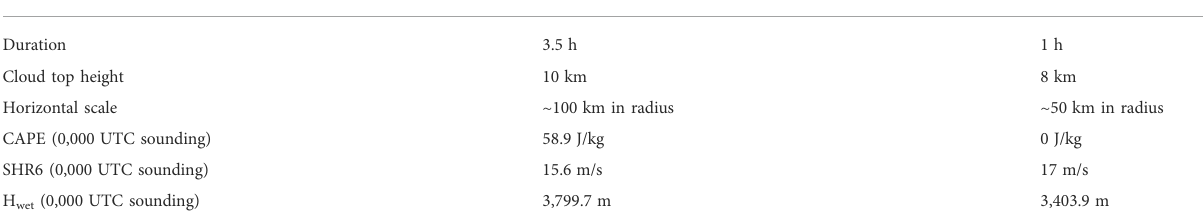
TABLE 4 Characteristics of two types of